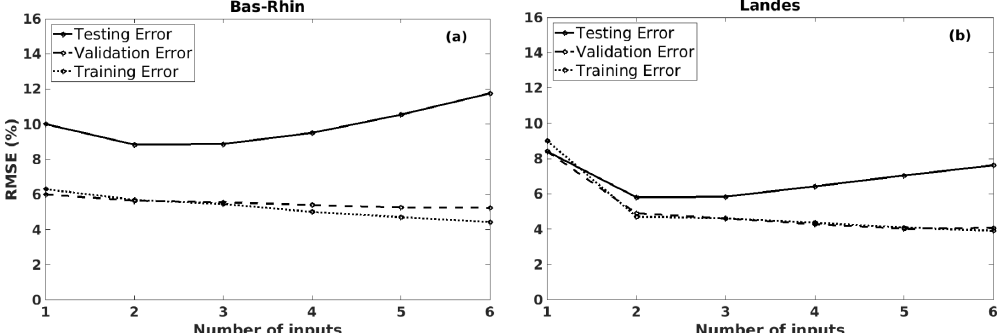
Figure 8. The training, validation, and testing RMSE values of the predicted grain maize yield anomalies, using different LIN models (with 12 potential predictors) by increasing the number of inputs, in (a) Bas-Rhin and (b) Landes.